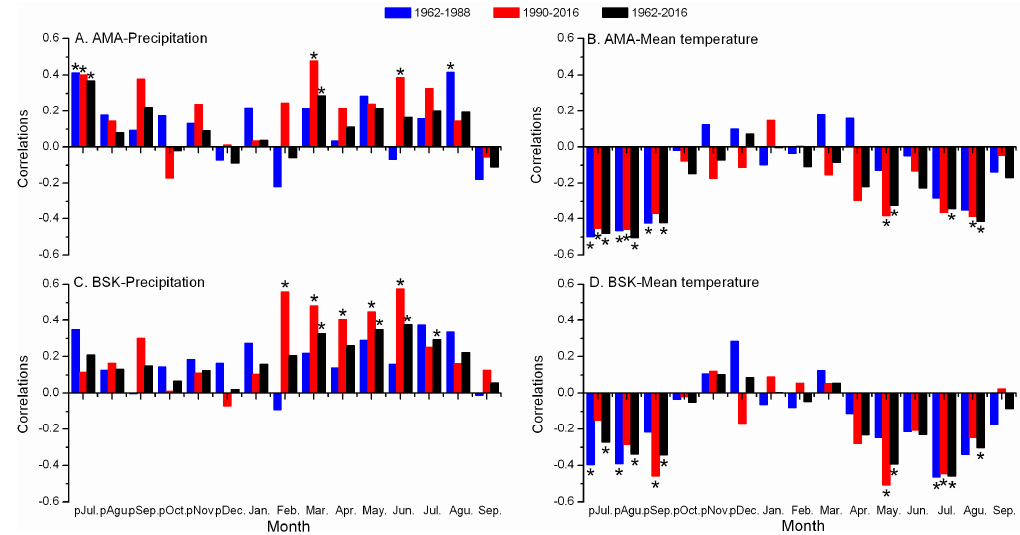
Figure 5. Pearson correlations between the tree-ring chronologies and climatic data (precipitation and mean temperature) in the periods 1962–1988 (blue bars), 1990–2016 (red bars), and 1962–2016 (black bars): ( A ) AMA and precipitation, ( B ) AMA and mean temperature, ( C ) BSK and precipitation, and ( D ) BSK and mean temperature.